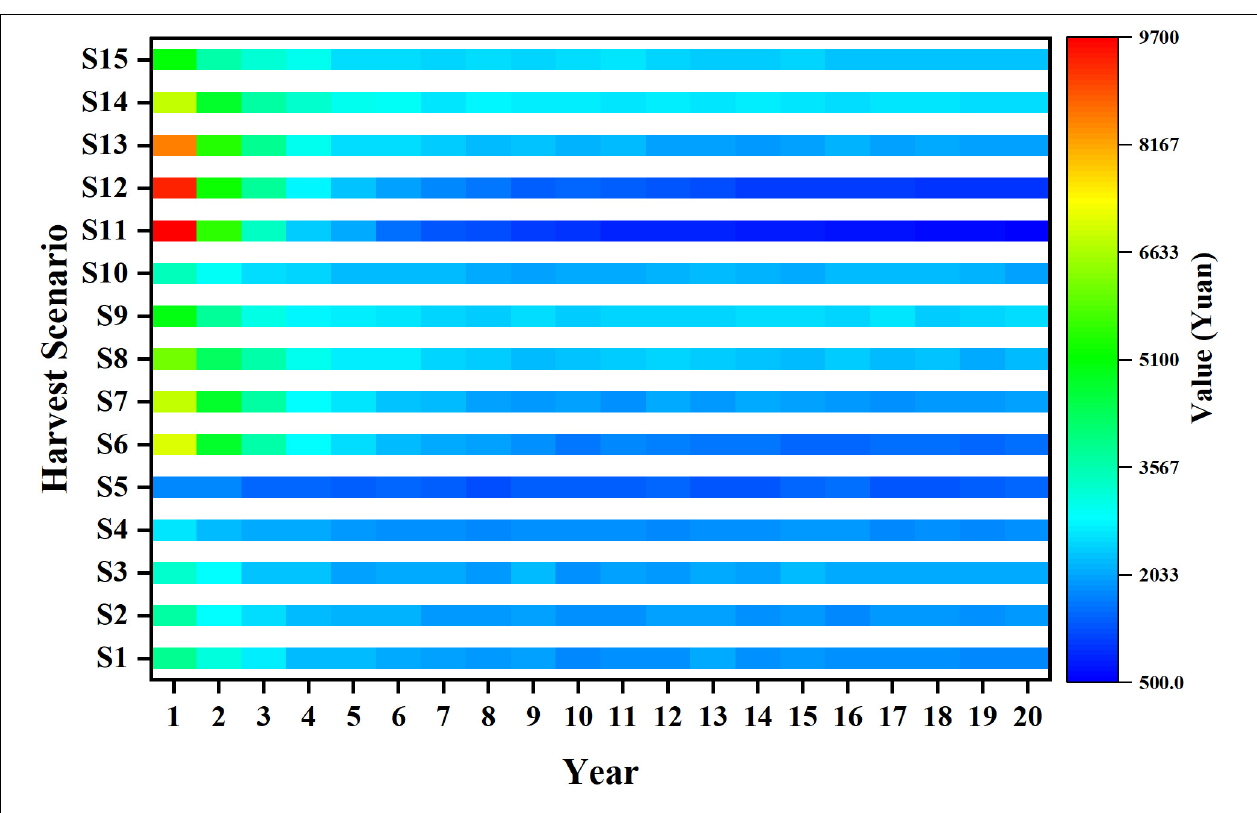
FIGURE 8 | Trends of value in different harvest scenarios.